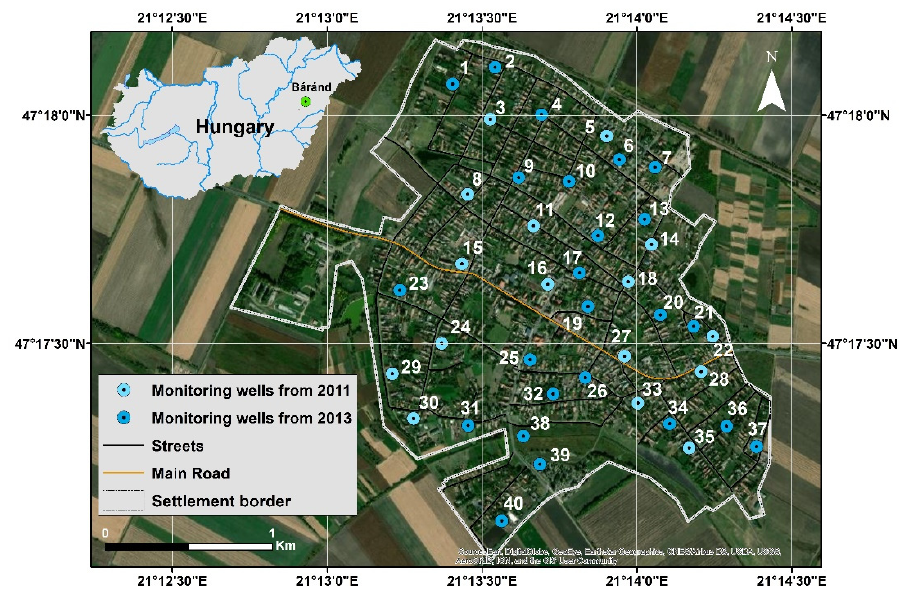
Figure 2. Location of the monitoring wells in the investigated settlement in Hungary.